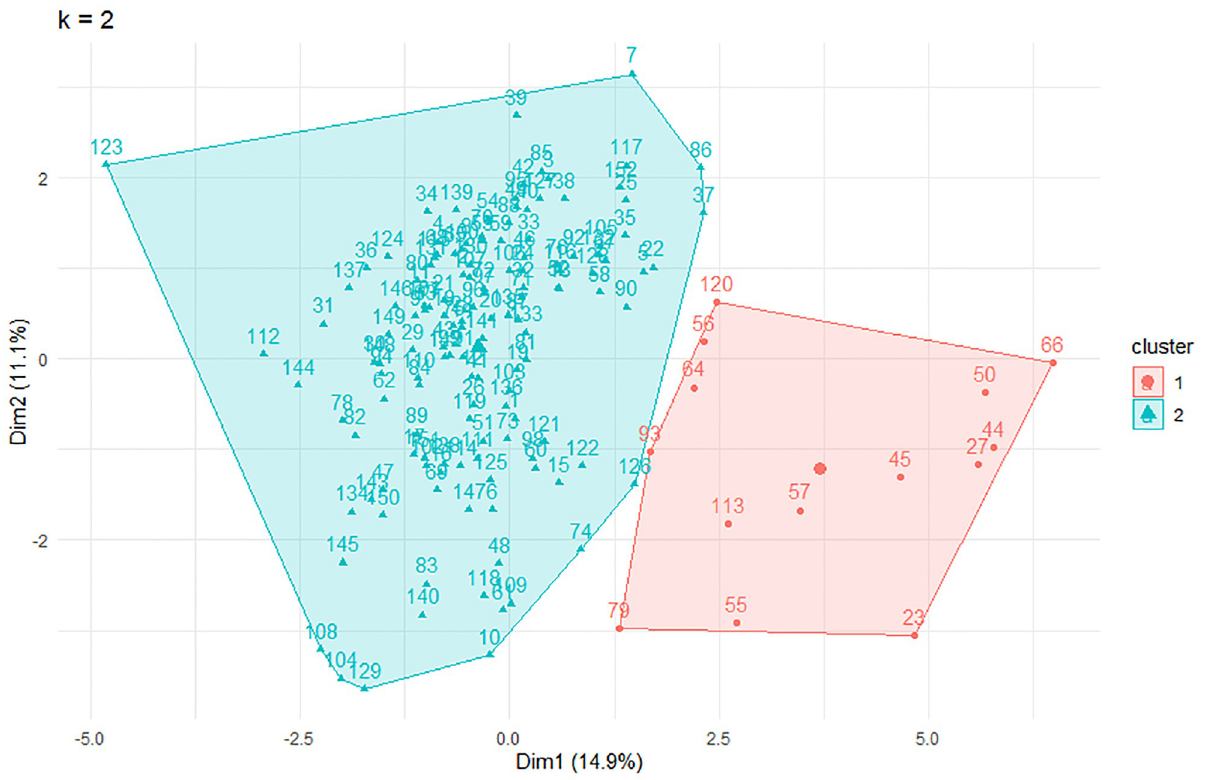
Fig 7. Biplot representation of K-means clustering using the first two principle components for 152 pomegranate genotype (numbers) according morphological and chemical traits.